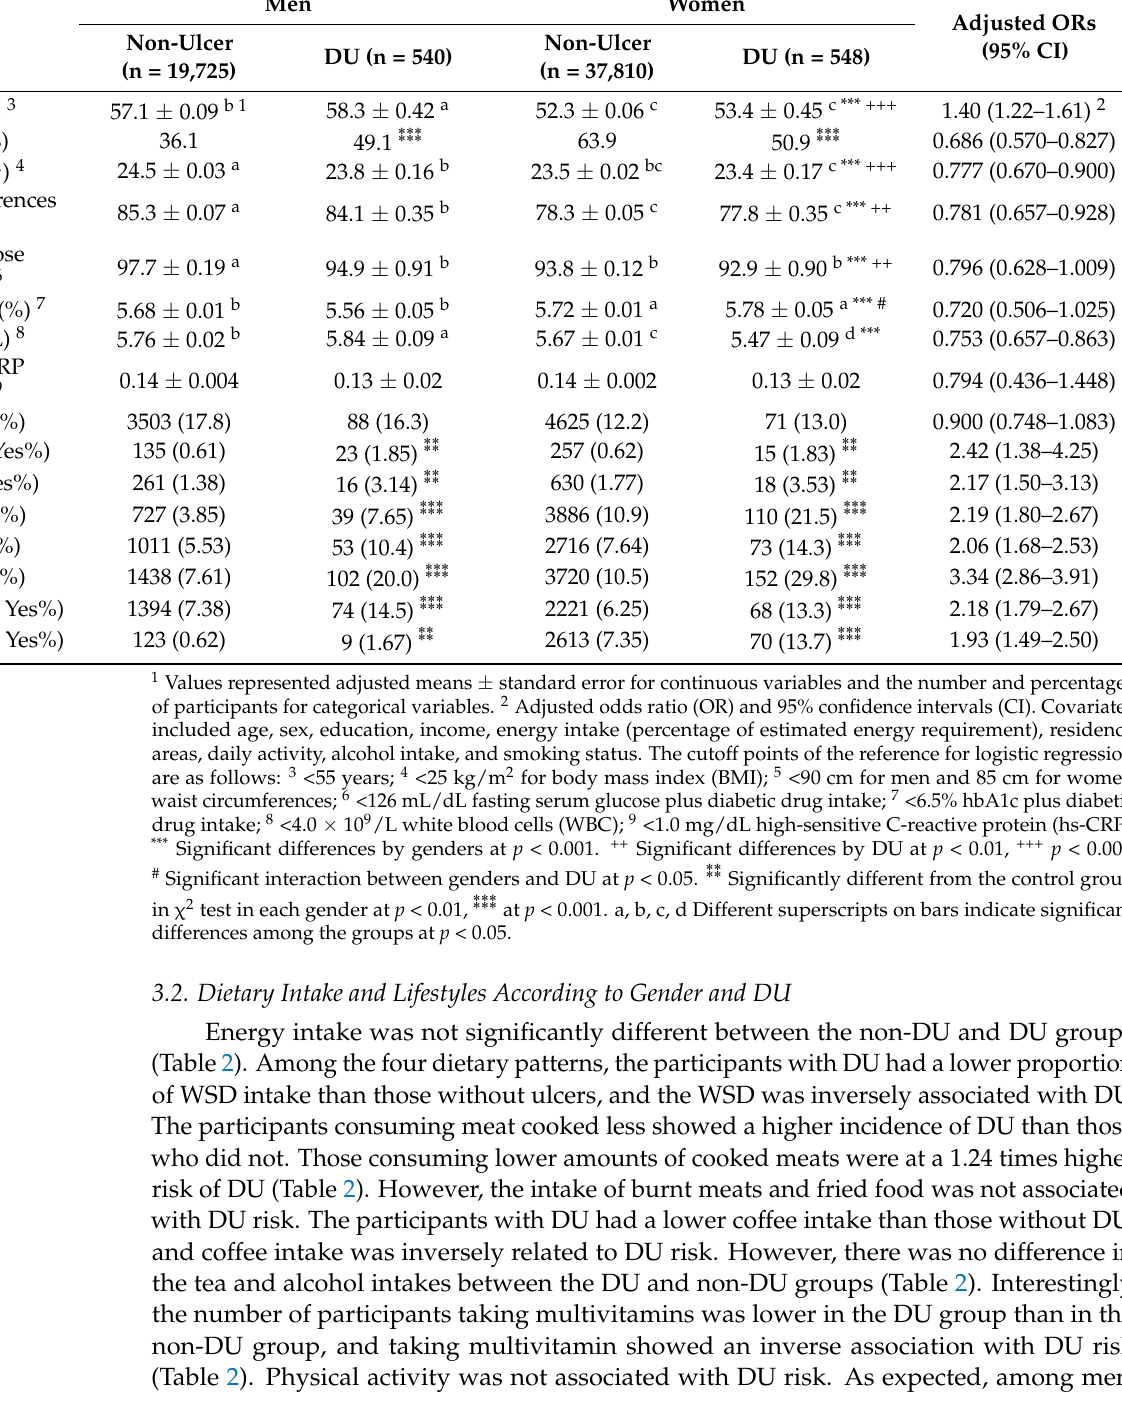
allergy, gastritis, and periodontitis was higher in the DU group than in the non-ulcer group, regardless of gender. The risk of DU was 2.06 – 3.34 times higher in patients with these immune-related diseases. Interestingly, the risk of osteoporosis is 1.93 times higher in those with DU. Table 1. General characteristics of the participants according to gender and duodenal ulcer. Table 1. General characteristics of the participants according to gender and duodenal ulcer. Table 1. General characteristics of the participants according to gender and duodenal ulcer. Table 1. General characteristics of the participants according to gender and duodenal ulcer. Table 1. General characteristics of the participants according to gender and duodenal ulcer. Table 1. General characteristics of the participants according to gender and duodenal ulcer. Table 1. General characteristics of the participants according to gender and duodenal ulcer. Table 1. General characteristics of the participants according to gender and duodenal ulcer. Men Table 1. General characteristics of the participants according to gender and duodenal ulcer. Table 1. General characteristics of the participants according to gender and duodenal ulcer. Table 1. General characteristics of the participants according to gender and duodenal ulcer. Table 1. General characteristics of the participants according to gender and duodenal ulcer. Table 1. General characteristics of the participants according to gender and duodenal ulcer. Table 1. General characteristics of the participants according to gender and duodenal ulcer.